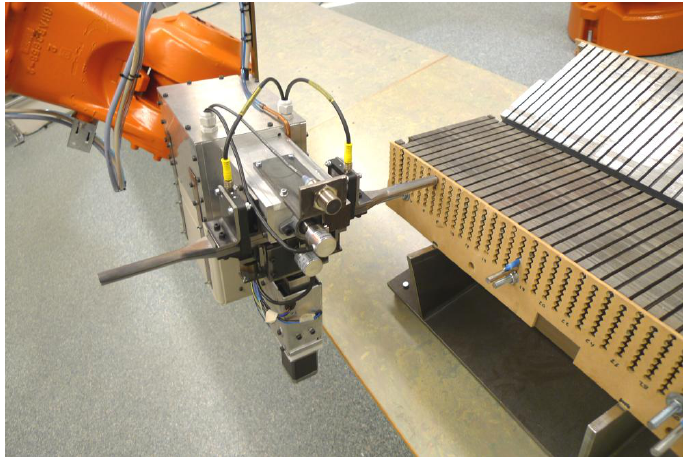
Figure 9. The robot-held cable feeder tool is positioned with one end of the cable guiding tube against a slot hole on the stator section prototype side, using the calibrated WOCS.